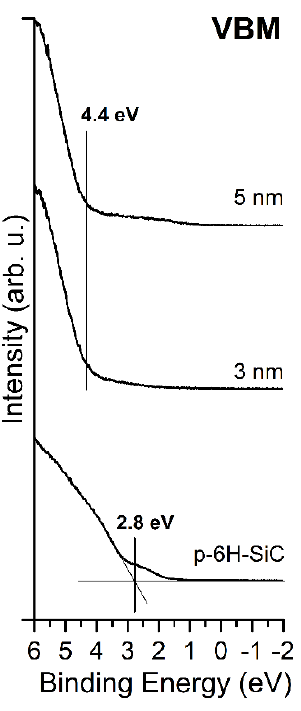
Figure 4. Band gap width determination of MgO layers from the onset of O 1s energy loss spectra. The average thickness of the layer is 5 nm.